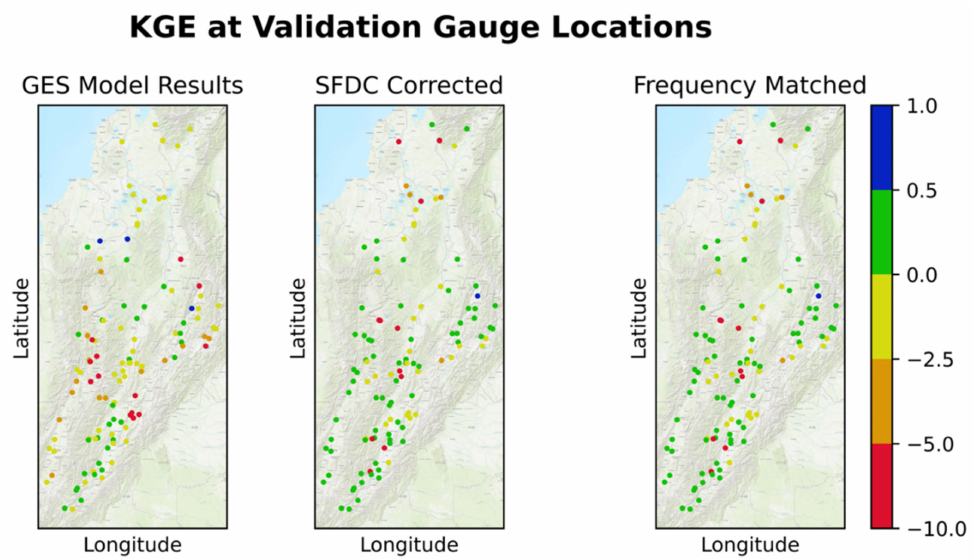
Figure 10. Maps of validation gauge locations colored by KGE metric values for uncorrected, SFDC- corrected, and frequency-matched corrected